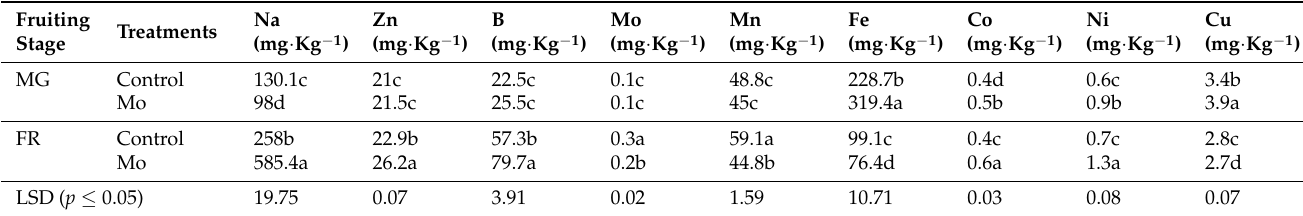
Table 6. Micronutrient concentrations in fruit peel of loquat as affected by the foliar application of molybdenum. Fruiting Treatments Stage